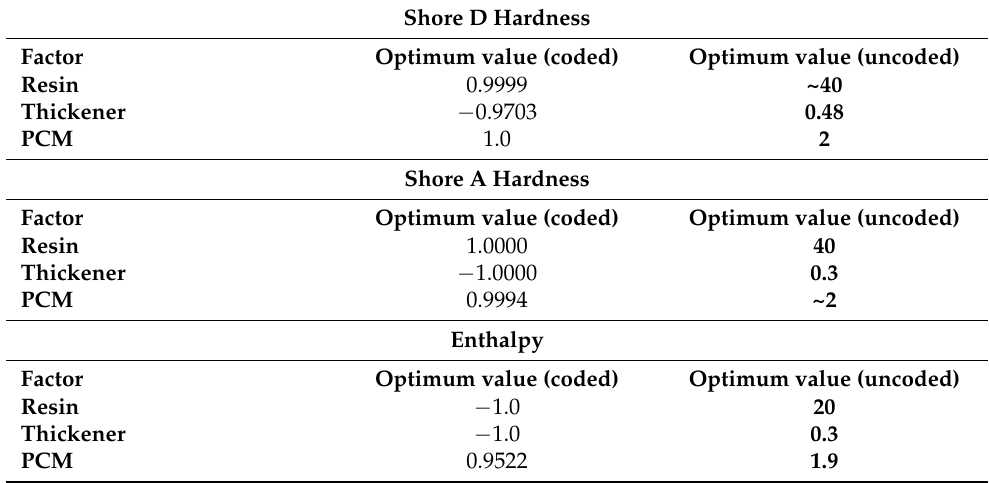
Table 5. Optimized values for Shore D/A hardness and enthalpy, expressed as coded and uncoded values.